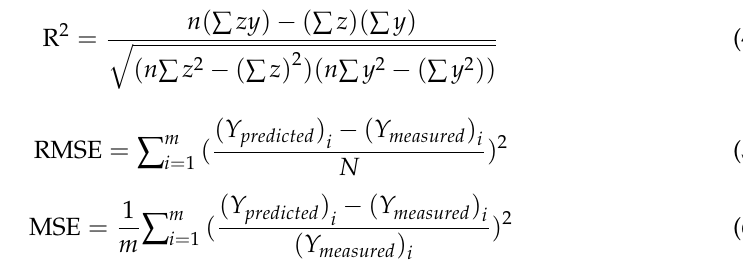
Figure 21. Prediction model for parameter estimation: R 0 vs. SOC.